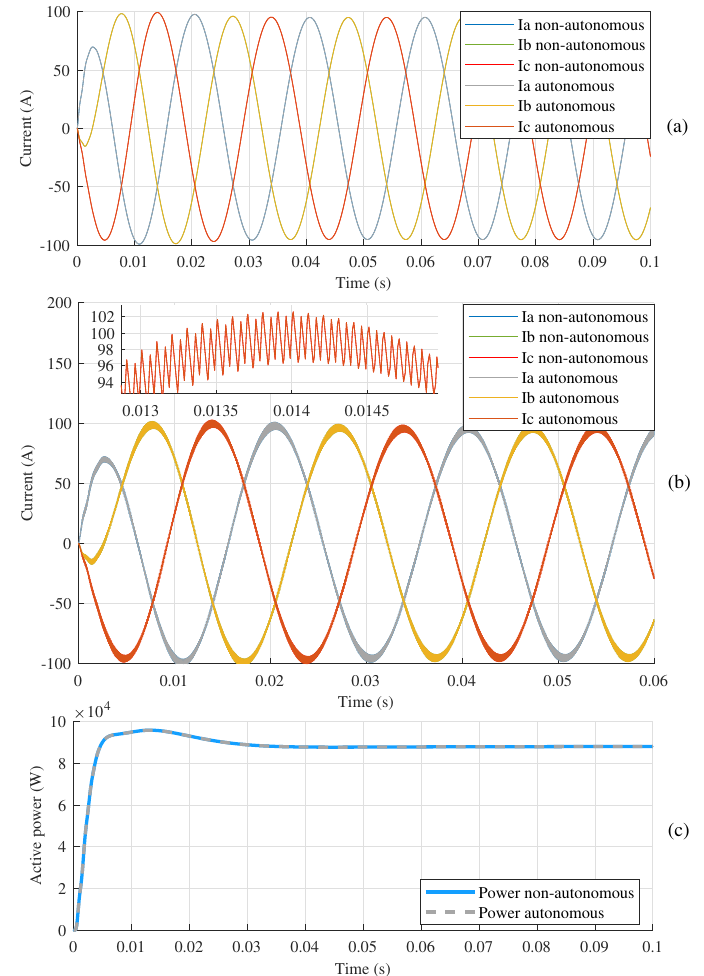
Figure 4. Comparison of the autonomous test system against the non-autonomous test system. In ( a ), the comparison of the DG1 output current signals for fundamental frequency is shown; in ( b ), the comparison of the DG1 output current signals for the commutated model is shown; and in ( c ), the comparison of the active power injected to the load for the commutated case is